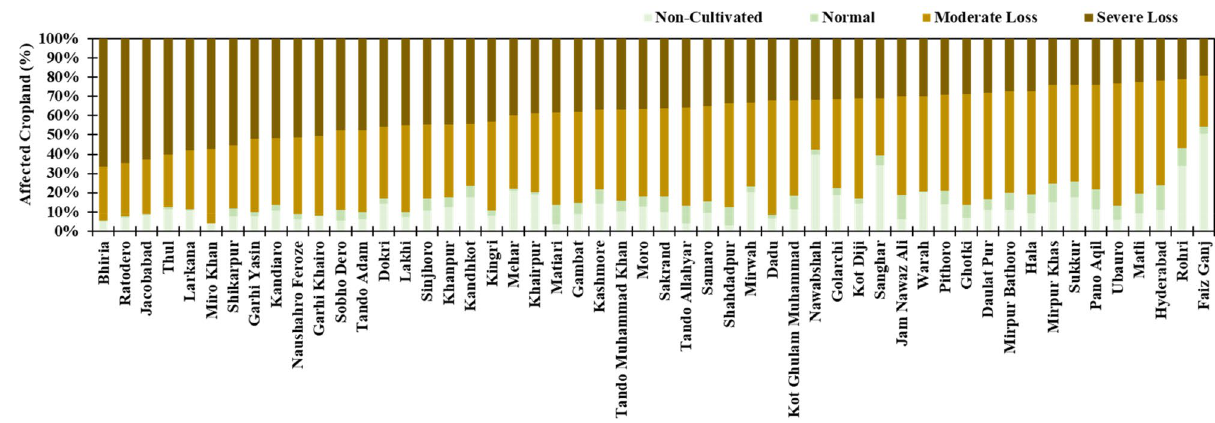
Figure 8. Tehsil-wise loss and damage to cropland derived from the NDVI difference